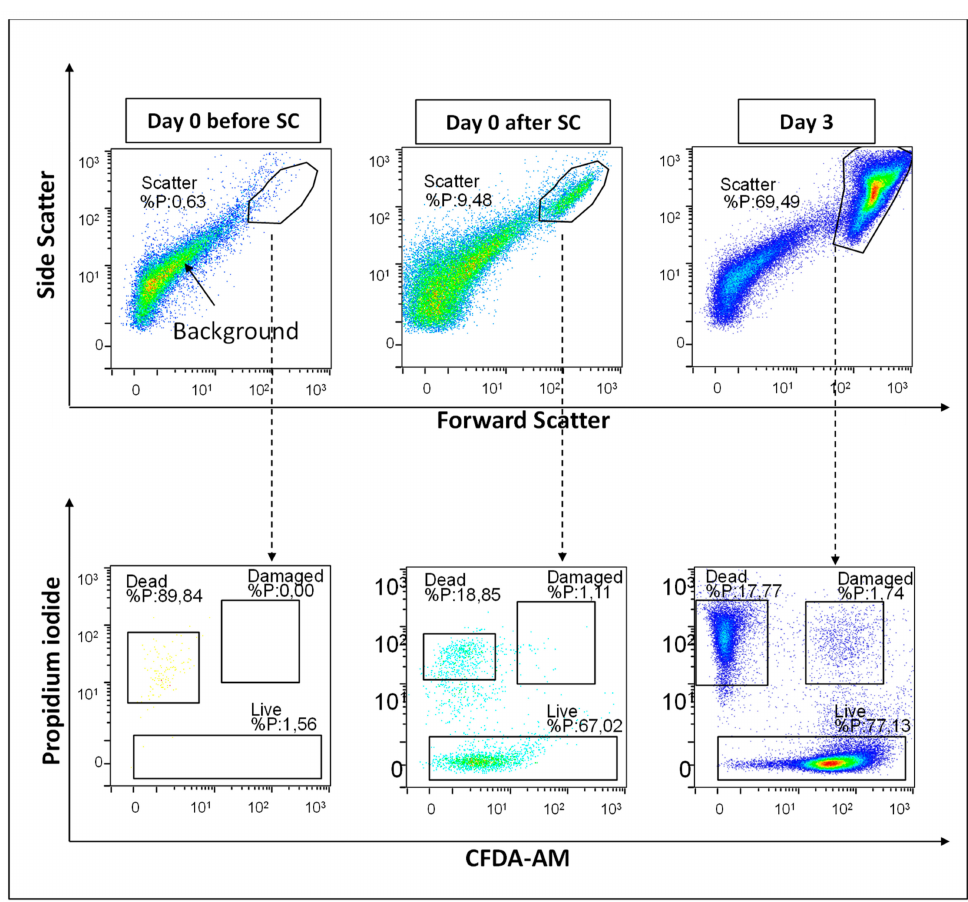
Figure 2. FCM analysis and gating strategy for the CFDA-PI protocol. The different colours indicate the cell density (blue/green = low cell density; yellow/red: high cell density). Before SC: must before SC inoculation; after SC: must after SC